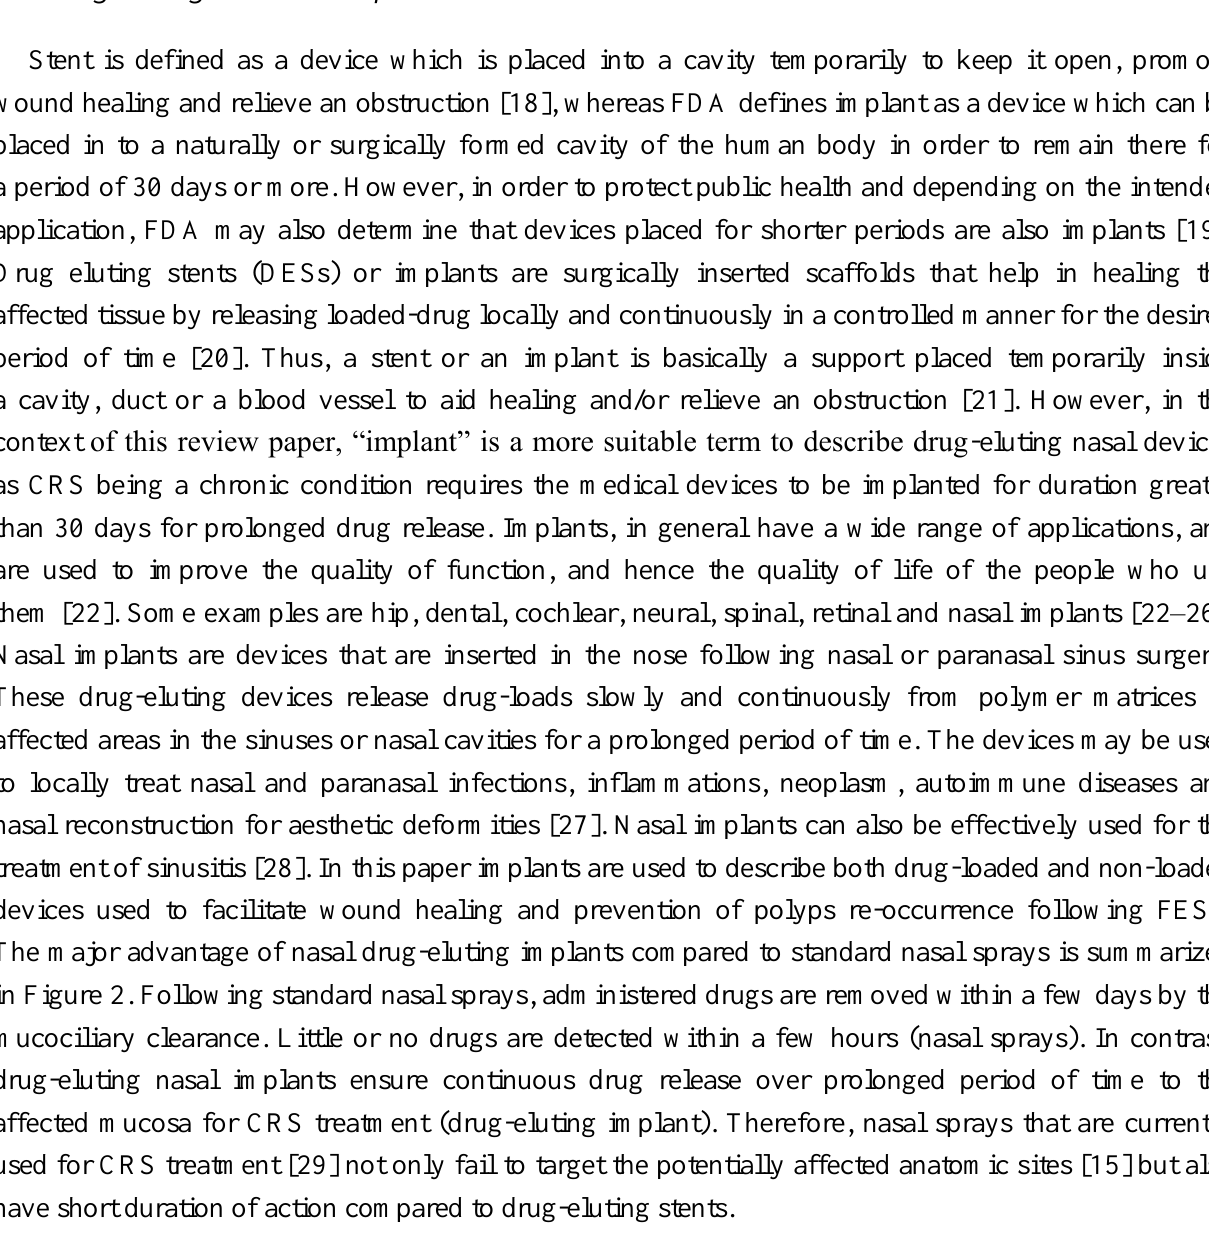
Figure 2. Comparison of the plots of nasal drug concentration versus time, obtained after administration of nasal sprays and drug-eluting implants. Nasal sprays show rapid clearance of the drug from the nasal mucosa as compared to locally acting